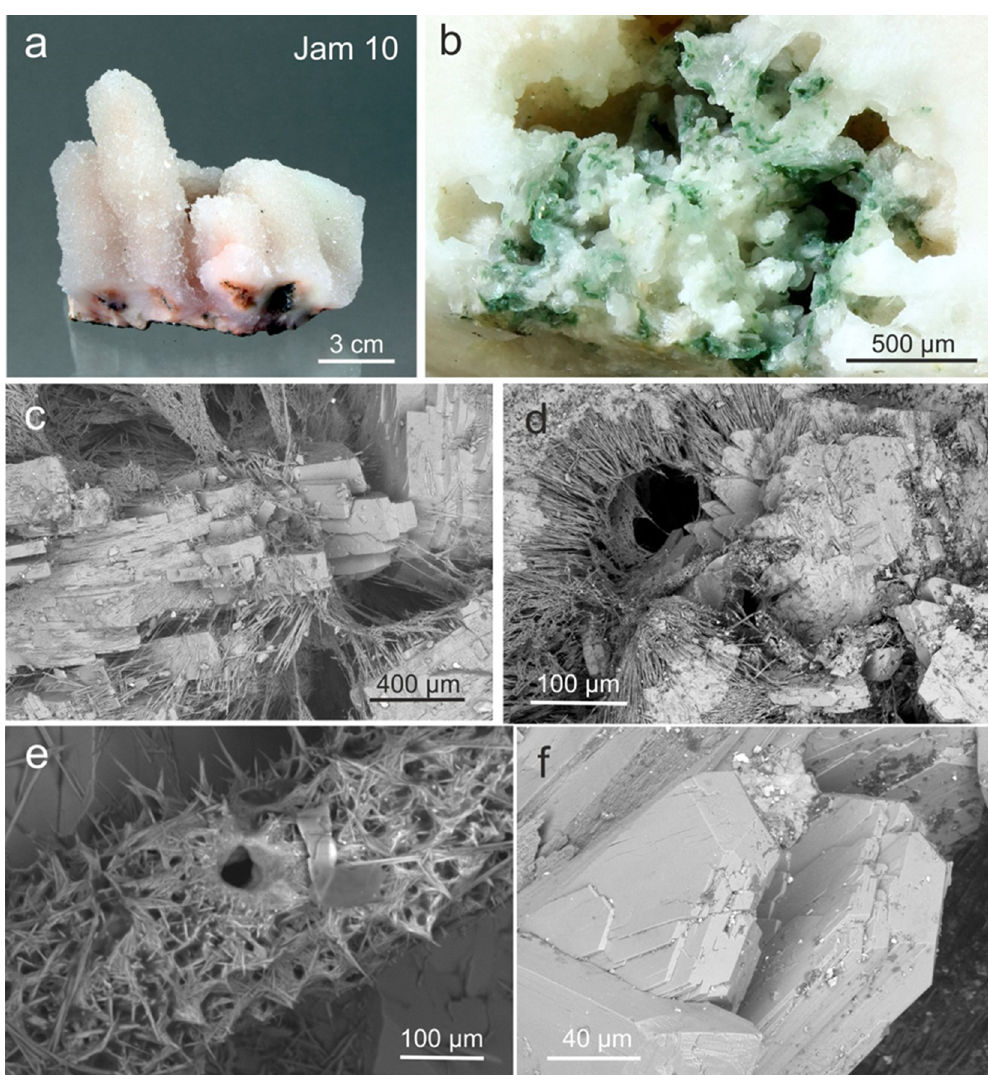
Figure 17. Images of sample Jam 10 (Jamner): ( a ) pseudo-stalactitic SiO 2 aggregate inheriting filamentous cores; ( b ) details of the green filamentous center of the silica aggregates; ( c ) SEM micrograph of zeolites showing platy heulandite-clinoptilolite crystals overgrown by fibrous mordenite; ( d ) SEM image of a spherical hole surrounded by heulandite-clinoptilolite and fibrous bundles of mordenite; ( e ) tubular, reticular aggregate (probably surrounding the former filamentous core) consisting of fine filaments several µm in diameter (celadonite) and adhering mordenite fibers; ( f ) SEM micrograph of blocky stilbite crystals; for chemical analyses of the minerals see Table S6.